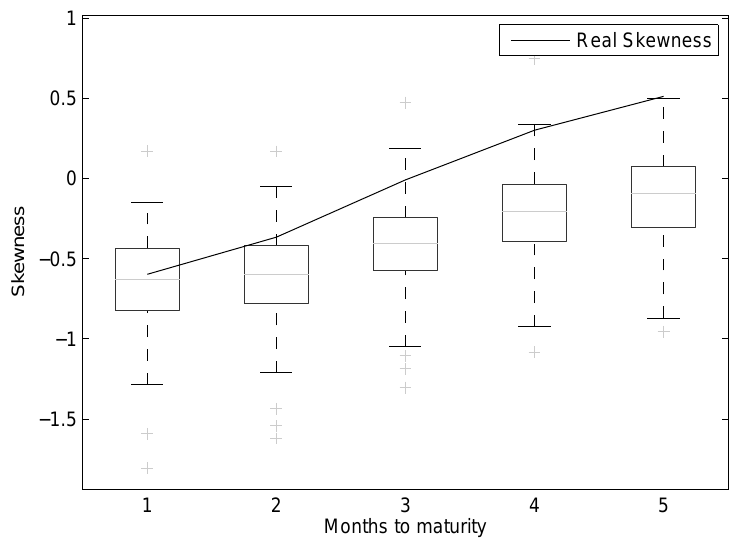
Figure 11. Box plots of the skewness of simulated time